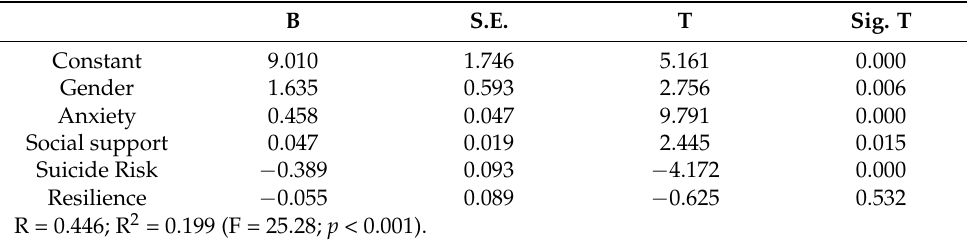
Table 4. Model of multiple linear regression analysis (dependent variable = COVID-19 fear). B S.E. T Sig.